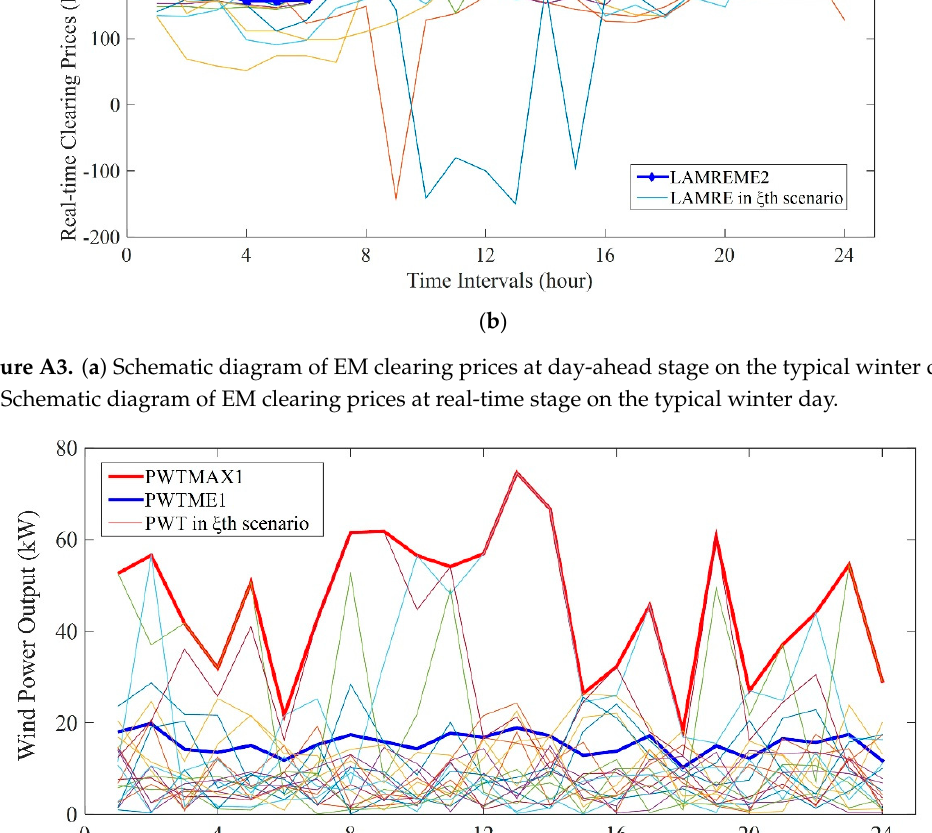
Figure A4. The generated stochastic scenarios for wind power outputs on the typical winter day.